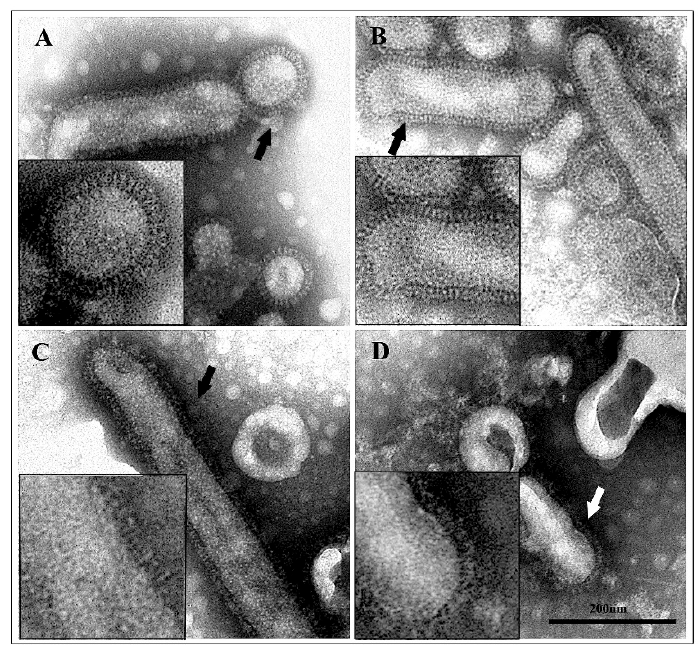
Figure 5. Negative staining of influenza virus particles. At pH 7.4, virions show well-ordered surface spikes ( A ); at pH 6.0, spikes are still well-defined ( B ); after exposure to pH 5.0, virions show a disordered surface ( C ); at pH 4.0, the spikes appear very discontinuous ( D ). Inserts show greater detail.